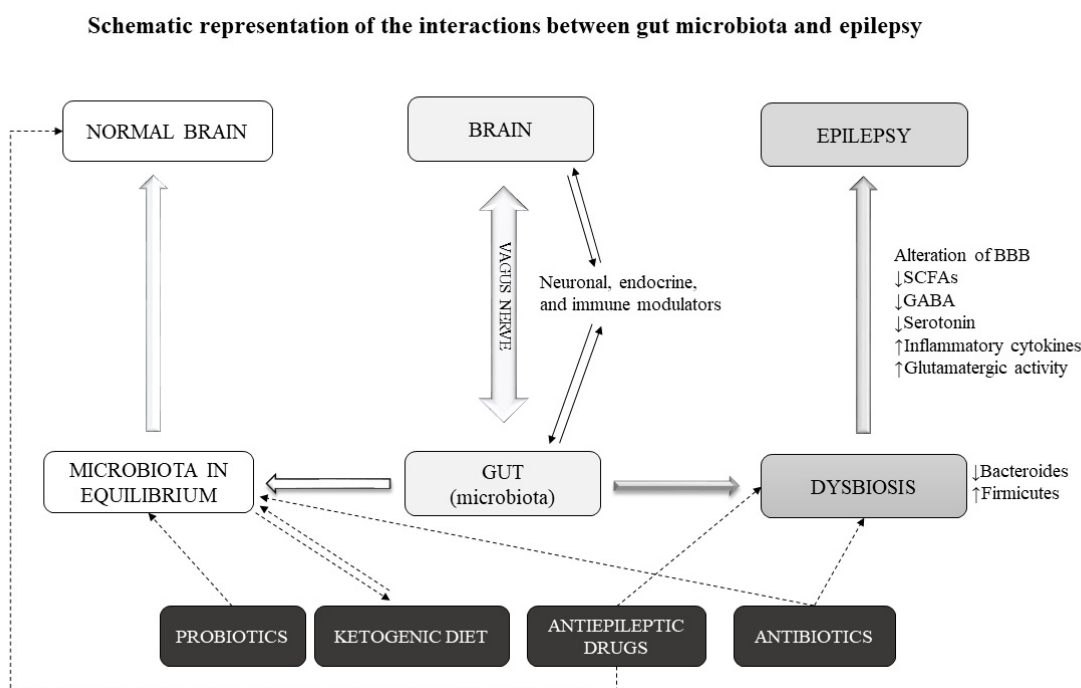
Figure 1. Schematic representation of the interactions between gut microbiota and epilepsy. Intestinal microorganisms can communicate with the brain in various ways, including the production of microbial metabolites, activation of the vagus nerve and modulation of the endocrine and immune response. In conditions of dysbiosis, alterations can occur that favor the onset of epileptic seizures. A reduction in short-chain fatty acids (SCFAs) alters the blood brain barrier, allowing the entry of toxins and inflammatory cytokines. Furthermore, a reduced production of neurotransmitters such as GABA and serotonin in the gut–brain axis can contribute to increase glutamatergic activity in the brain and favor the onset of seizure. External agents (such as antibiotics, probiotics, antiepileptic drugs and ketogenic diet) can modify the gut microbiota in a favorable or opposite direction to epileptic seizures.